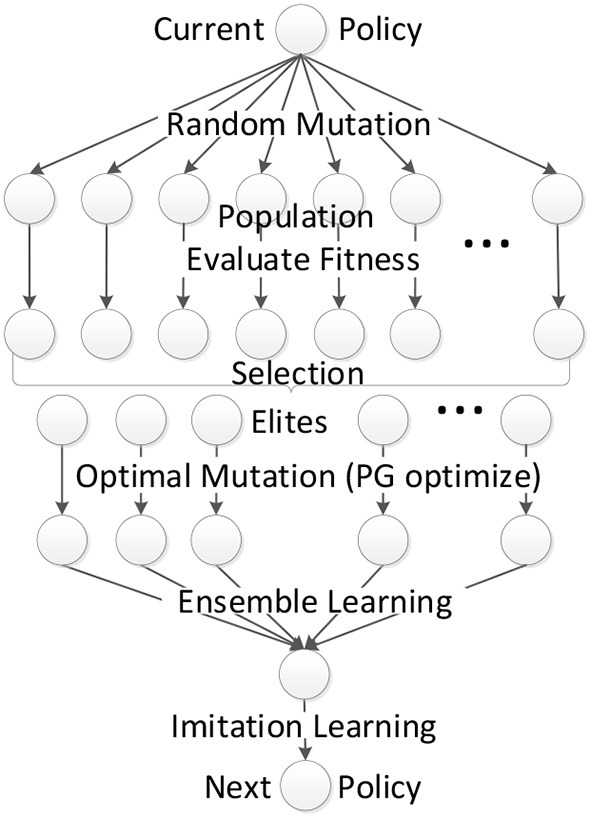
Framework of EPG.